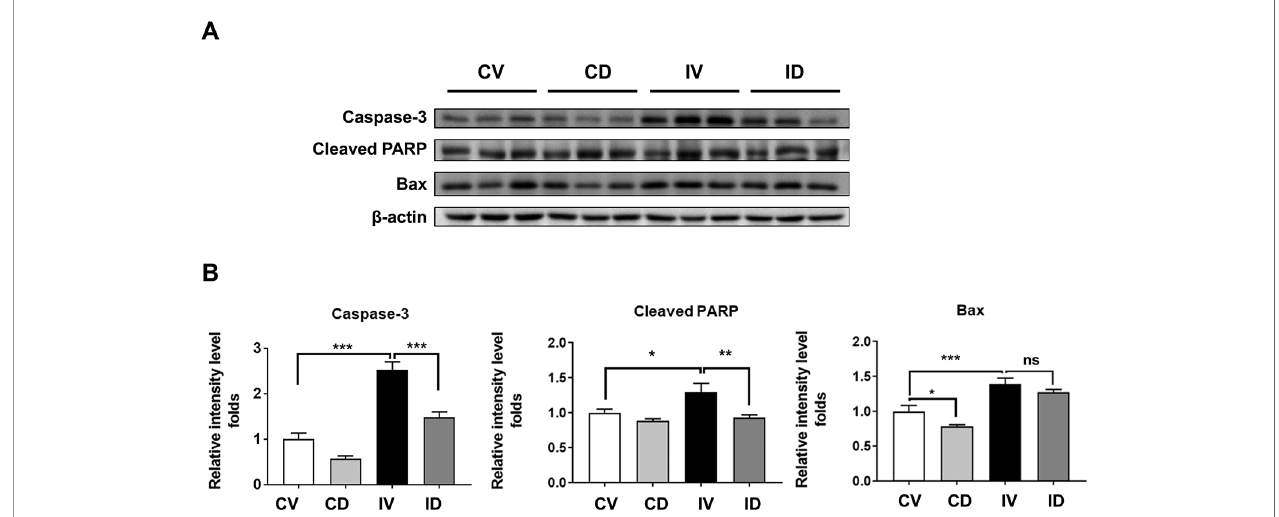
FIGURE 5 | Dulaglutide prevents apoptosis in disuse condition. (A) Immunoblotting and (B) quanti fi cation analyses of caspase-3, cleaved PARP, and Bax proteins in GA muscle. Beta-actin was used as the loading control. Data are showed as mean ± S.E.M, n = 5; *p < 0.05, **p < 0.01, ***p < 0.001. CV, control + vehicle; CD, control + dulaglutide; IV, immobilization + vehicle; ID, immobilization + dulaglutide; ns, not signi fi